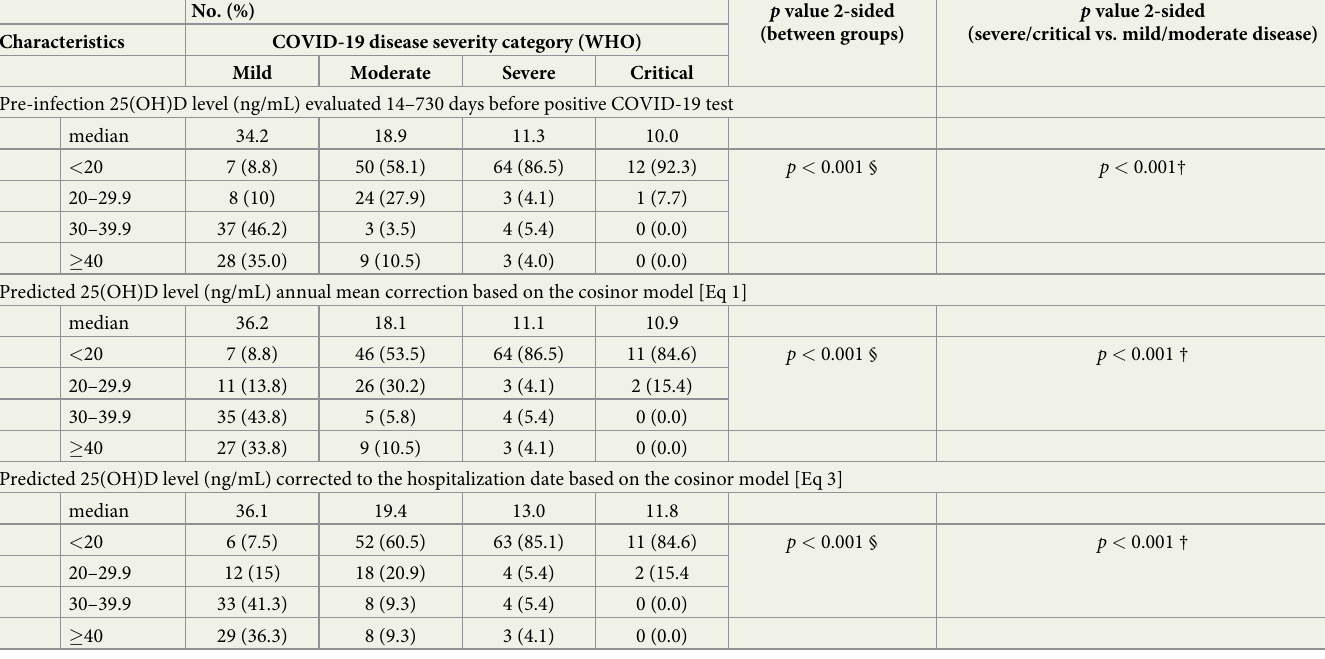
Table 3. 25(OH)D level stratified by COVID-19 disease severity category before and after cosinor correction models for the annual mean as well as each patient’s date of